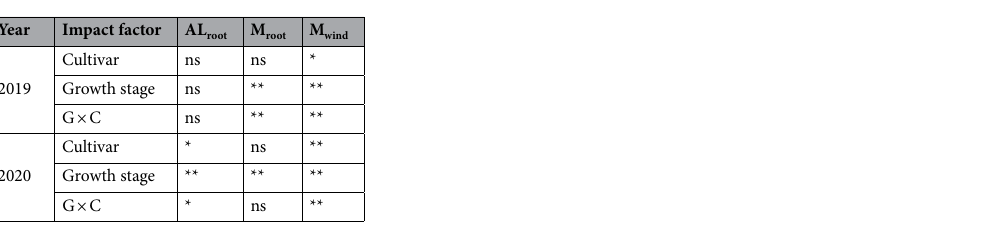
Figure 1. Variation trend of root anti-lodging index during whole growth period in maize.